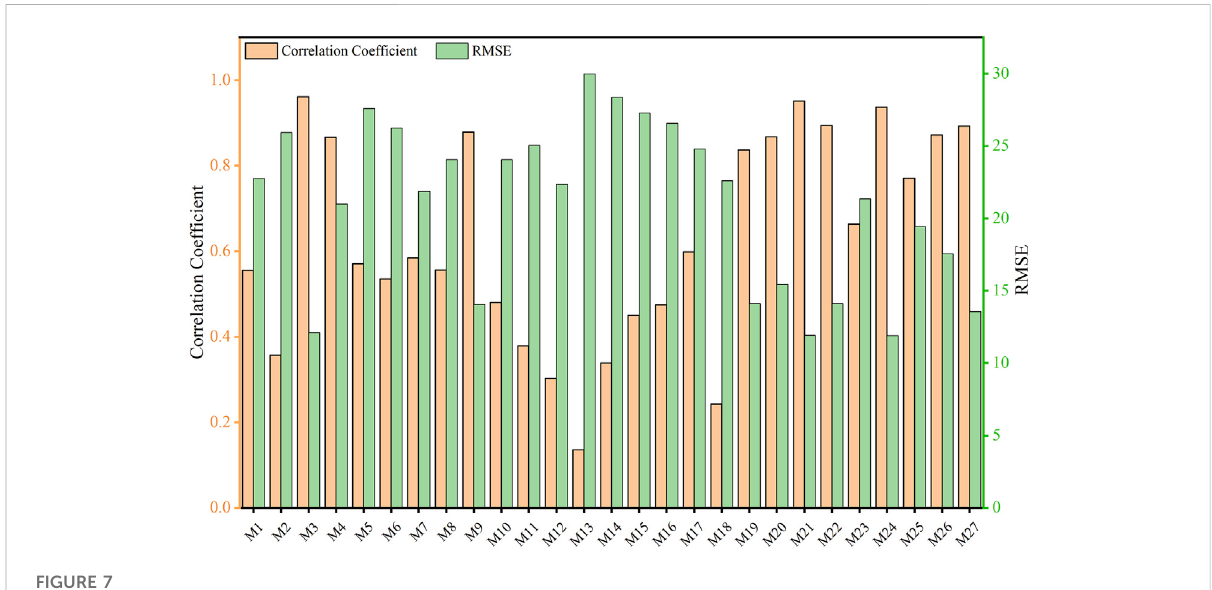
FIGURE 7 The correlation coef fi cient and RMSE for 27 WRF combination